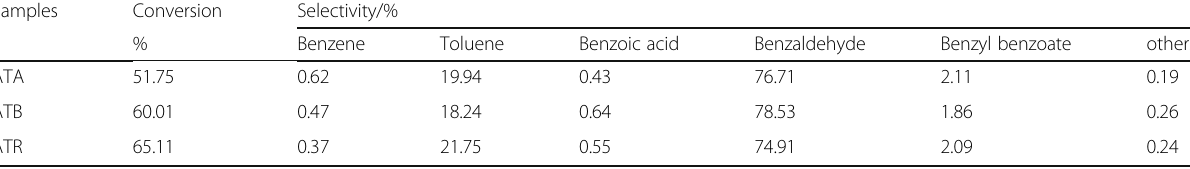
Table 3 Catalytic oxidation of benzyl alcohol over Au-Pd/TiO 2 catalysts in the absence of solvent